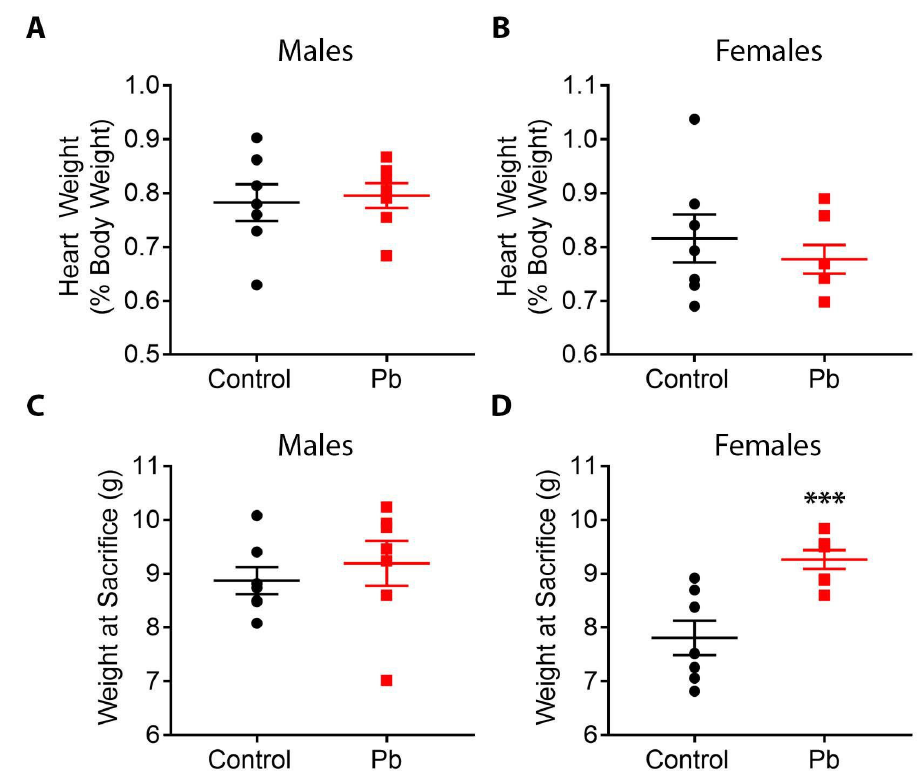
Figure 2. Heart weights as a percentage of body weight ( A , B ) and total body weights ( C , D ) for male and female offspring at sacrifice. N = 7 animals per group. *** p < 0.001. Linear mixed effects regres-